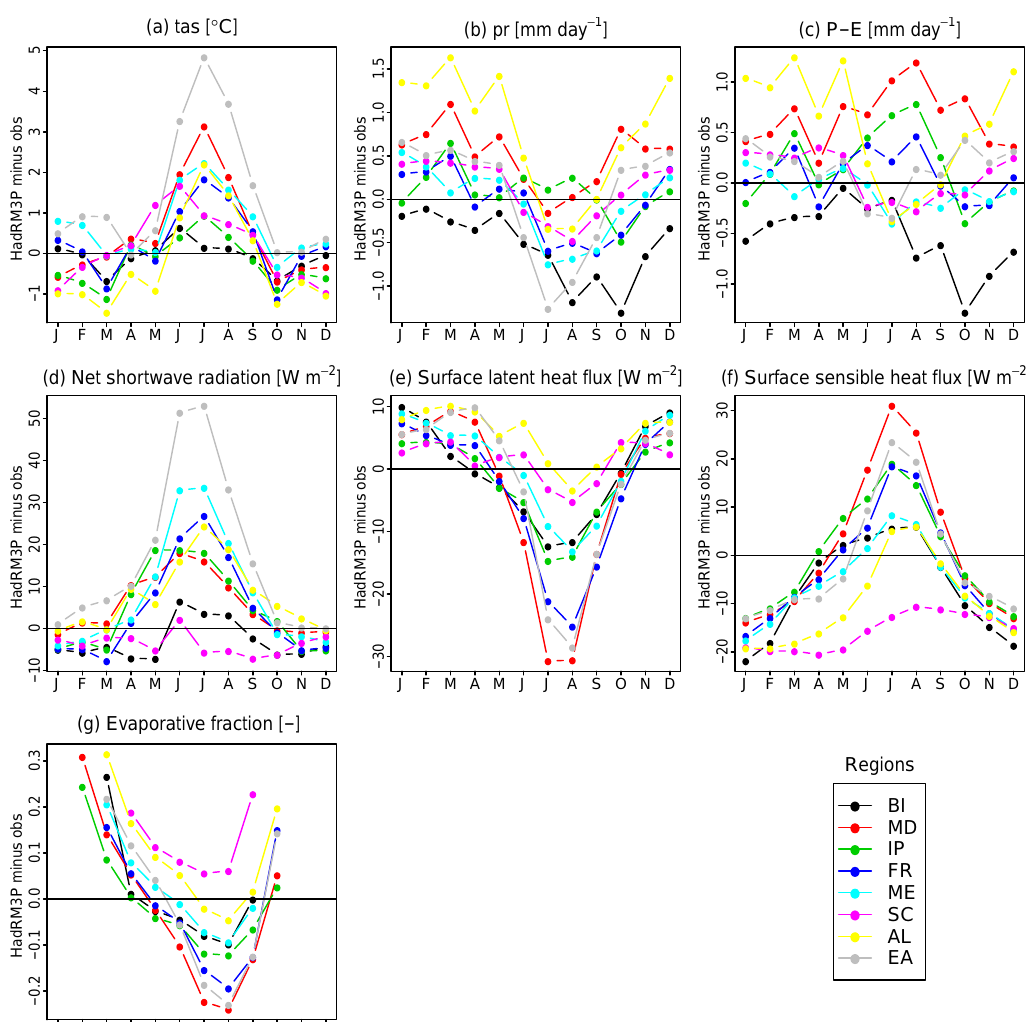
Figure 10. Seasonal cycle of HadRM3P biases from 1984 to 2006 in each region for (a) temperature, (b) precipitation, (c) precipitation minus evaporation, (d) net shortwave radiation at the surface, (e) surface latent heat flux, (f) surface sensible heat flux, and (g) evaporative fraction (i.e. the ratio of latent heat flux to the sum of sensible and latent heat fluxes). The observational datasets used are E-OBS for temperature and precipitation, SRB for radiation, and FLUXNET-MTE for surface fluxes and the evaporative fraction. P – E is computed using precipitation from E-OBS and evapotranspiration from